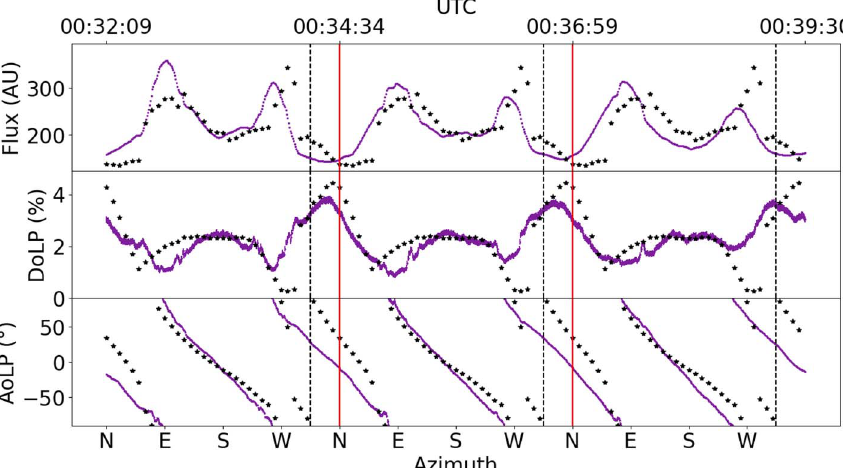
Fig. 10. 3 almucantar observations at 391.4 ± 5 nm (March 8, 2019): observations (in purple) and predictions for the model that best fi ts the data (Black stars H ). The model is a linear combination of ground and sky (including albedo) for a 3% polarised sky emission in a direction de fi ned by an azimuth of 35 (cid:3) and (cid:3) 3 (cid:3) elevation (see text for details). The dashed vertical black line indicates the direction of Skibotn. The picture of the sky at 557.7 nm is shown in Appendix A. The emissions at 391.4 nm (purple) are considered to be similar.